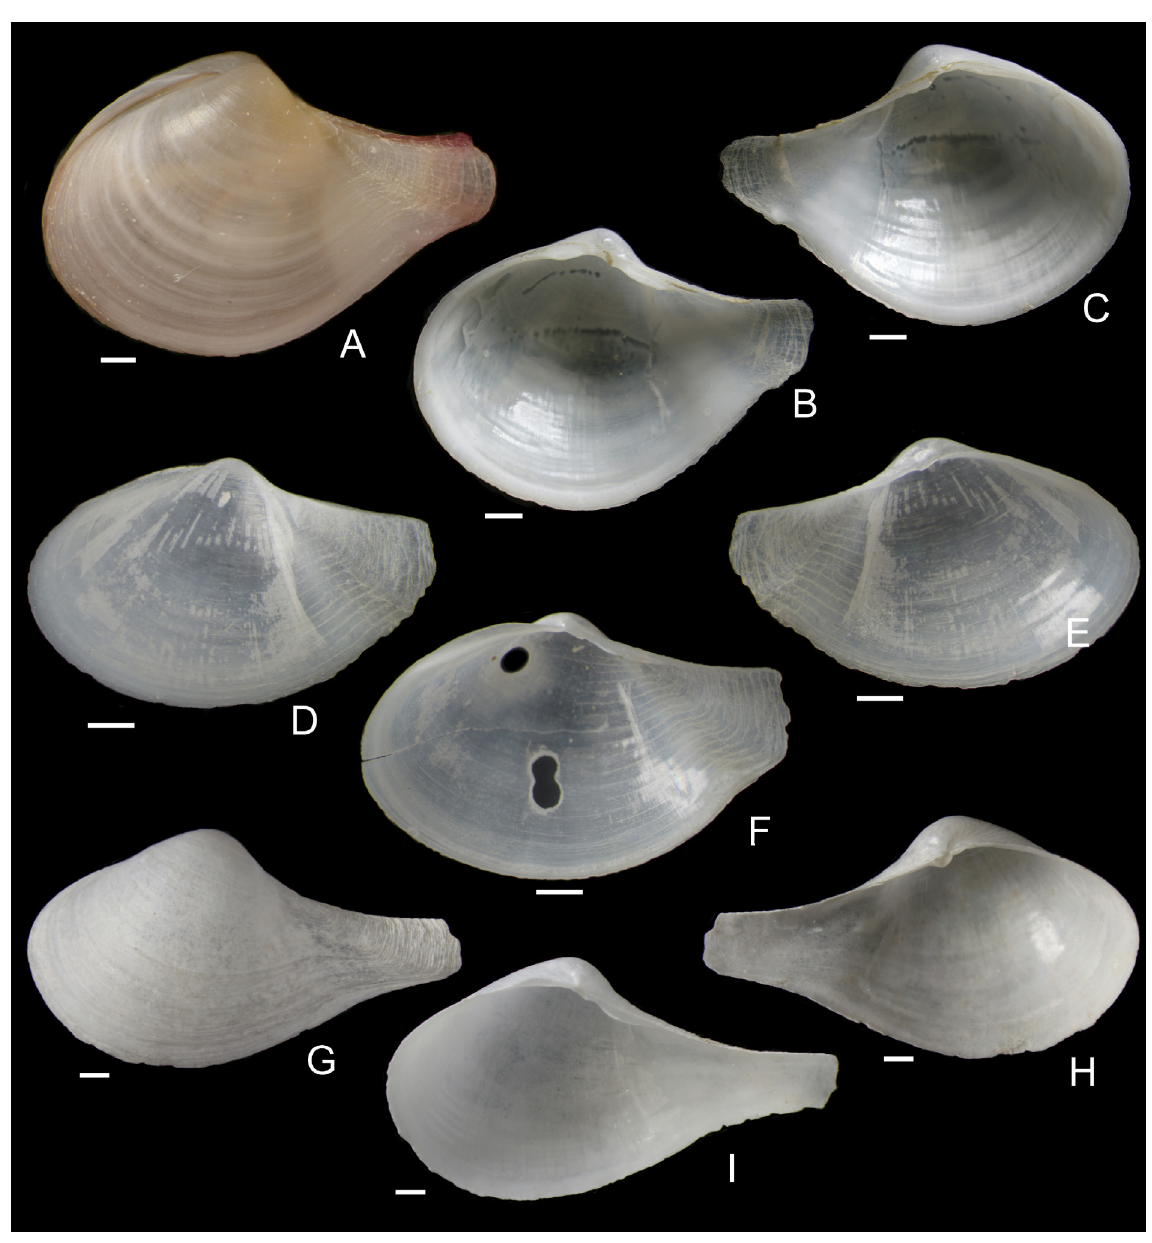
Fig. 42. Cuspidariidae. A–C . Rhinoclama teres (Jeffreys, 1882), BANGAL 0711, V5, 1631 m, 12.8 mm and 10.6 mm. D–F . Rhinoclama semistrigosa (Jeffreys, 1882), BANGAL 0711, V7, 1462 m, 9.1 and 8.7 mm. G–I . Cuspidaria cf. rostrata (Spengler, 1793), BANGAL 0711, V3, 818 m, 14.6 and 15.2 mm. Scale bars = 1